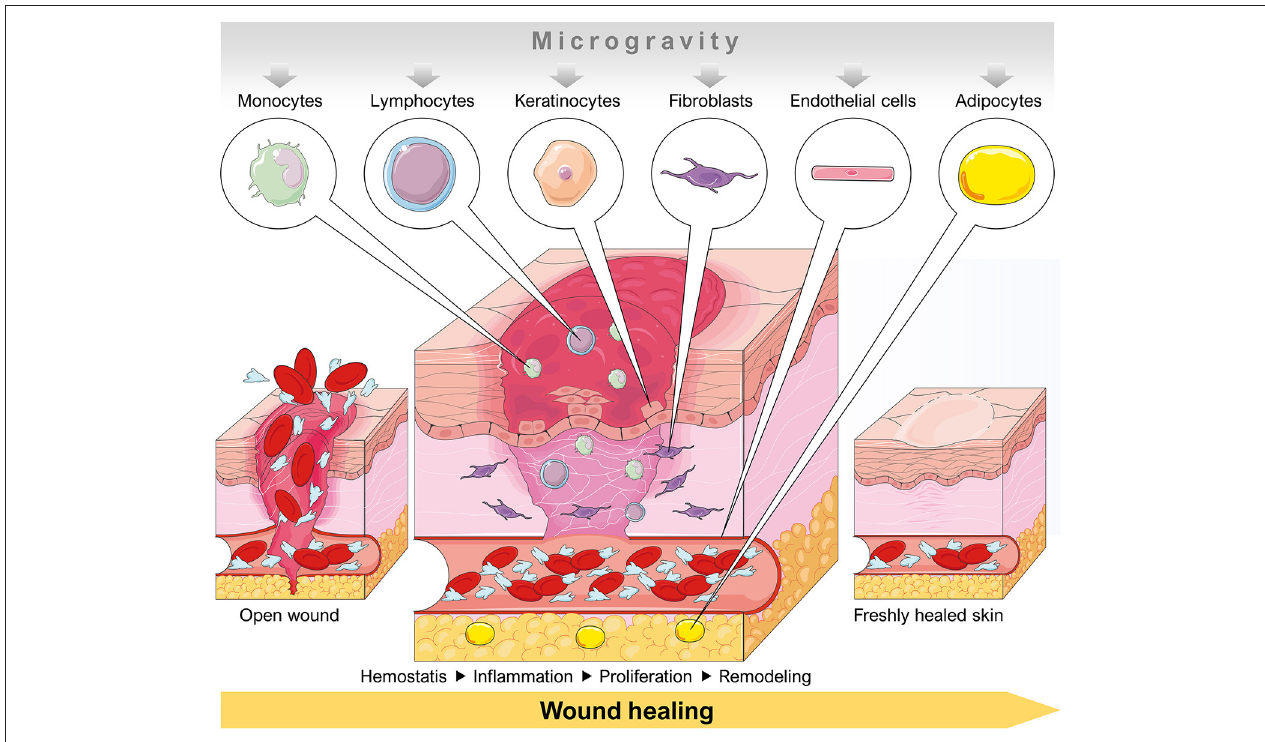
FIGURE 2 | Schematic overview of a dermal wound healing process involving cell types that are influenced by a microgravity environment. Parts of the figure are drawn using pictures from Servier Medical Art (https://smart.servier.com), licensed under a Creative Commons Attribution 3.0 Unported License (https://